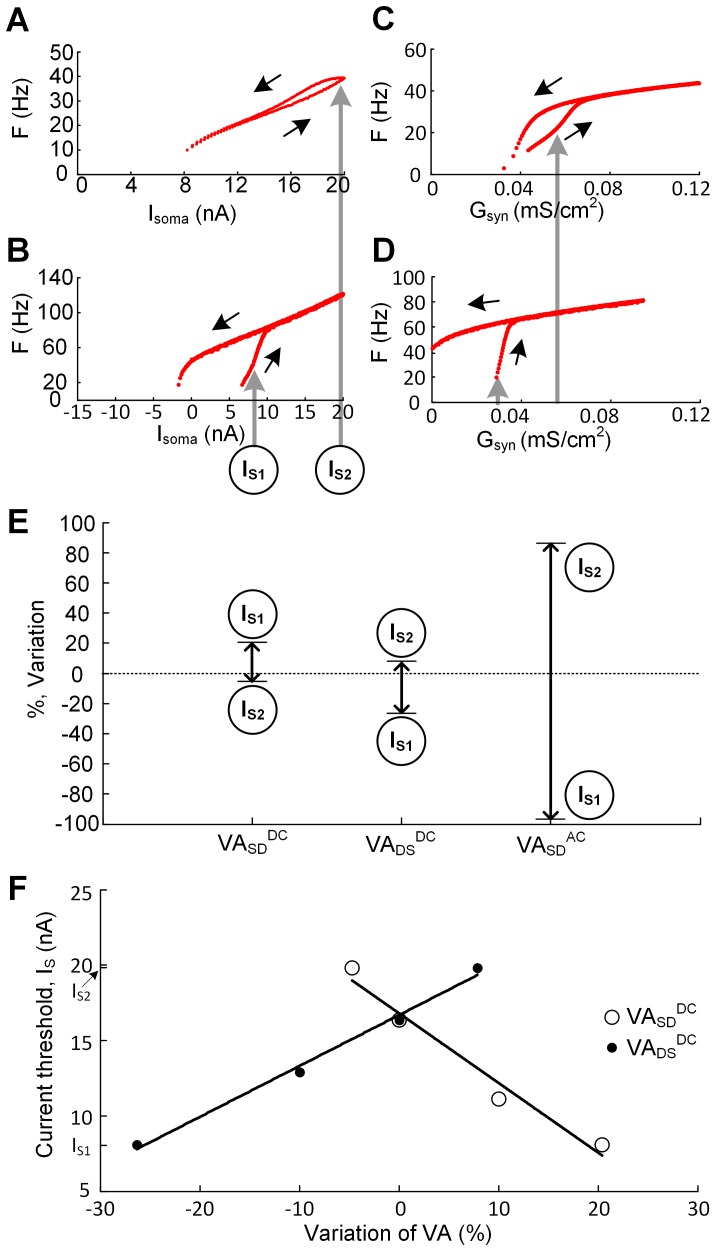
Sensitivity of cellular excitability to the VA factors.Using the same reduced model and ramp stimulation protocols used in Figure 2(H) & (I), F-Isoma and F-Gsyn relationships were simulated while varying individual VA factors independently. (A), (B). F-Isoma curves with VASD
DC decreased by 4.7% and increased by 20.4% from its original value (0.76). Circled letters, IS1 (8.1 nA) and IS2 (19.8 nA), on vertical gray lines indicate decreased and increased current threshold for initiating firing acceleration as a result of changing the VASD
DC. Black arrows indicate the rising and falling phase of triangular current stimulation to the soma. (C), (D). F-Gsyn curves with VASD
DC changed by the same variation (%) as applied to (A) and (B). Vertical gray arrows indicate increased (about 0.055 mS/cm2, left column) and decreased (about 0.029 mS/cm2, right column) threshold-Gsyn for the firing acceleration as a result of varying the VASD
DC. Black arrows indicate the rising and falling phase of triangular change in Gsyn at the dendrite. (E). The percent variation in individual VA factors (VASD
DC, VADS
DC, VASD
AC) to produce the firing acceleration at either IS1 or IS2. 0% represents the original values of VA factors and minus sign in the ordinate indicates the decrease in VA factor values. (F). Relationship of threshold current (IS) for the firing acceleration and the percent variation in DC VA factors. Data points were fitted to a linear regression line. Note that RN for the reduced model was set to be 1.29 MΩ.